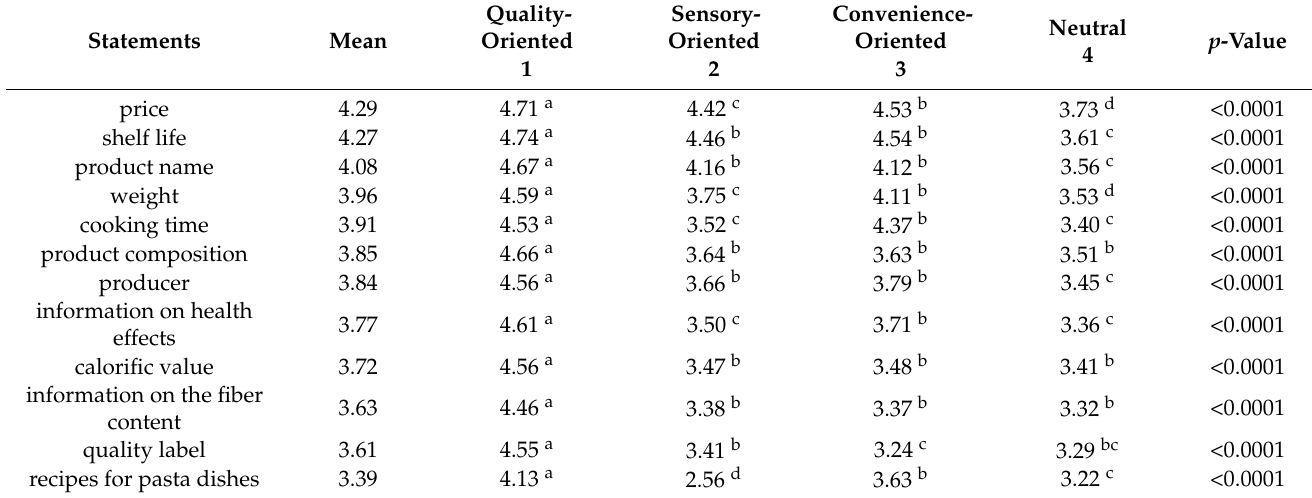
Table 6. Profile of segments in terms of statements referring to information on the pasta